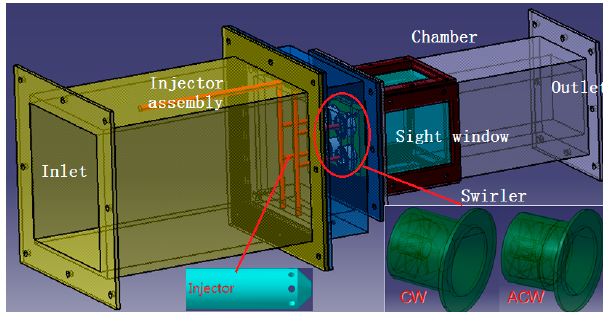
Figure 1. Geometric definition of four-point lean direct injection (LDI) combustor.